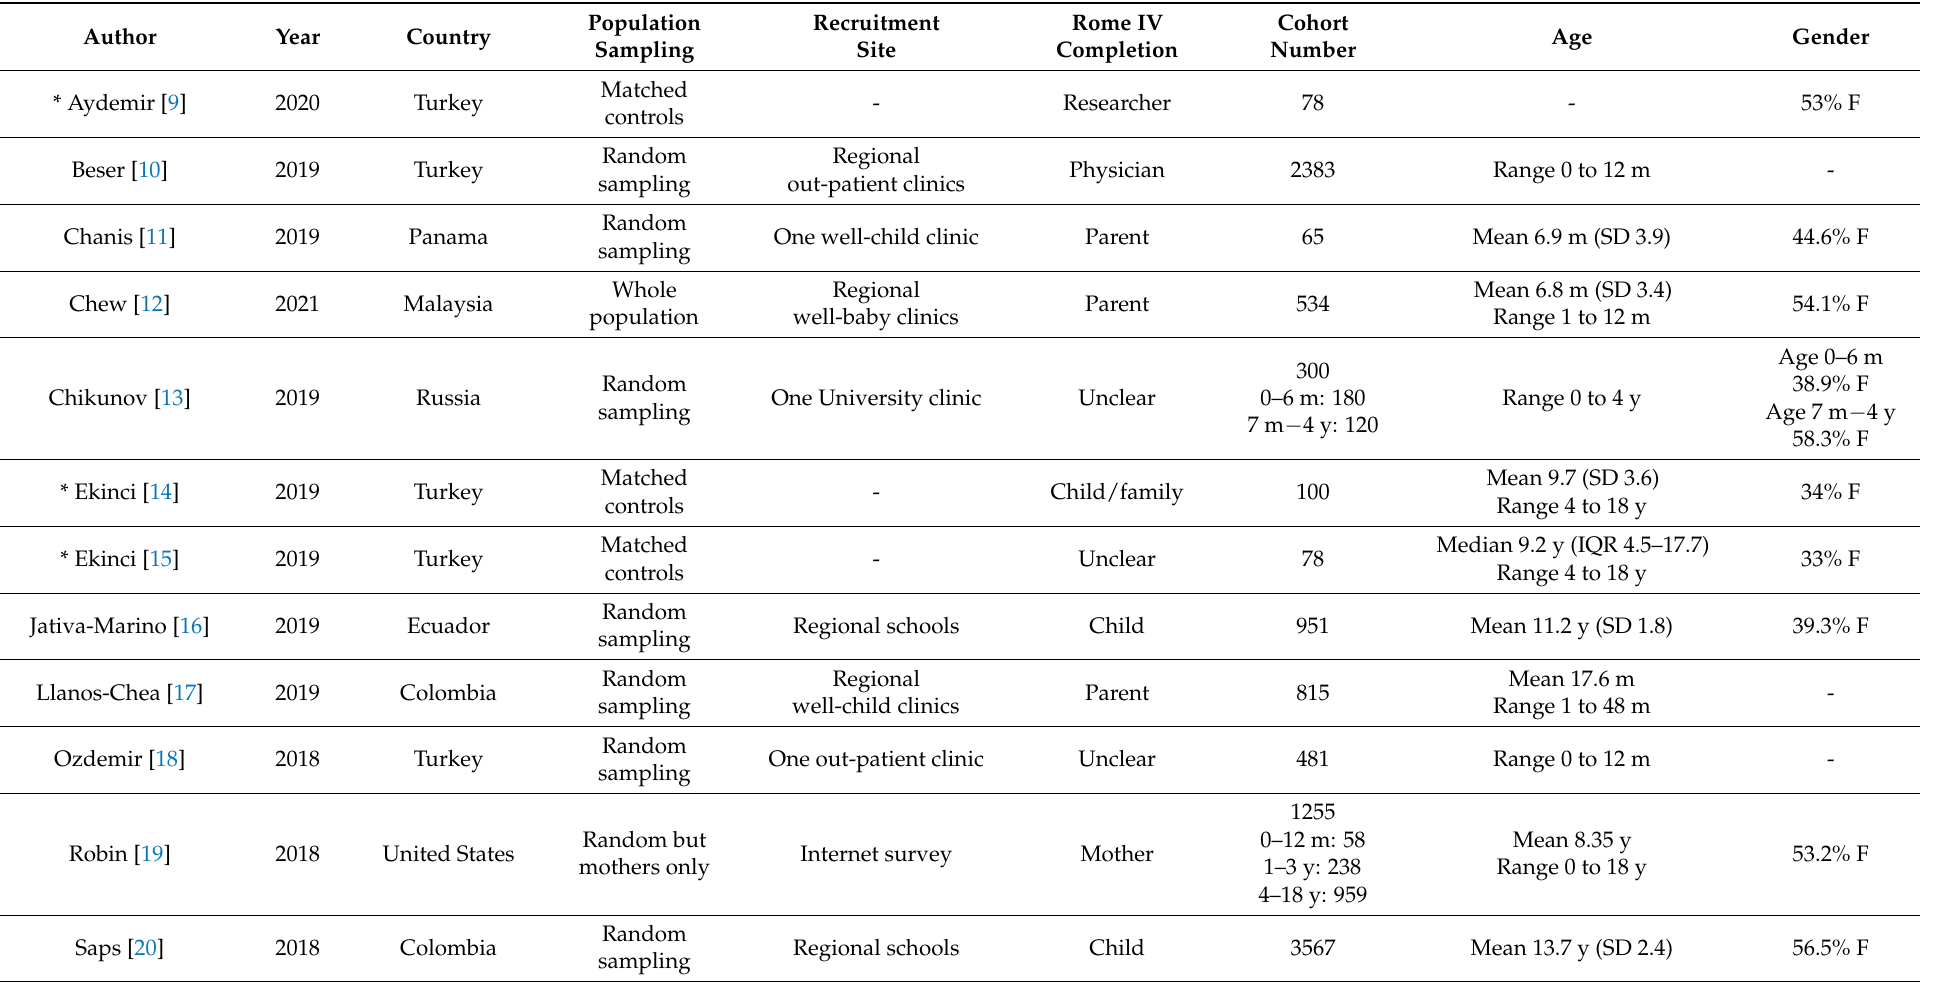
Table 1. Characteristics of studies included in data extraction